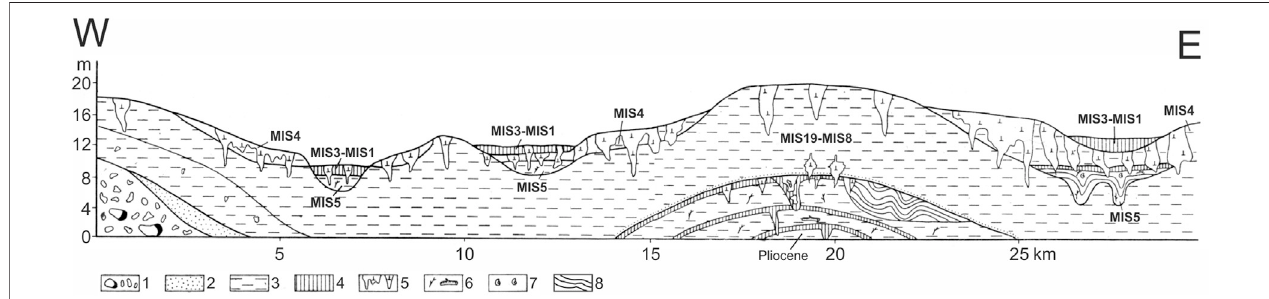
FIGURE 2 | Schematic section of deposits in the Oyogos Yar outcrop (Konishchev and Kolesnikov, 1981). Legend: 1 — coarse clastic material; 2 — sand; 3 — silty loam; 4 — peat; 5 — ice wedges; 6 — plant remains; 7 — freshwater mollusk remains; 8 — silty loams with lenticular layering. MIS — marine isotope stage.